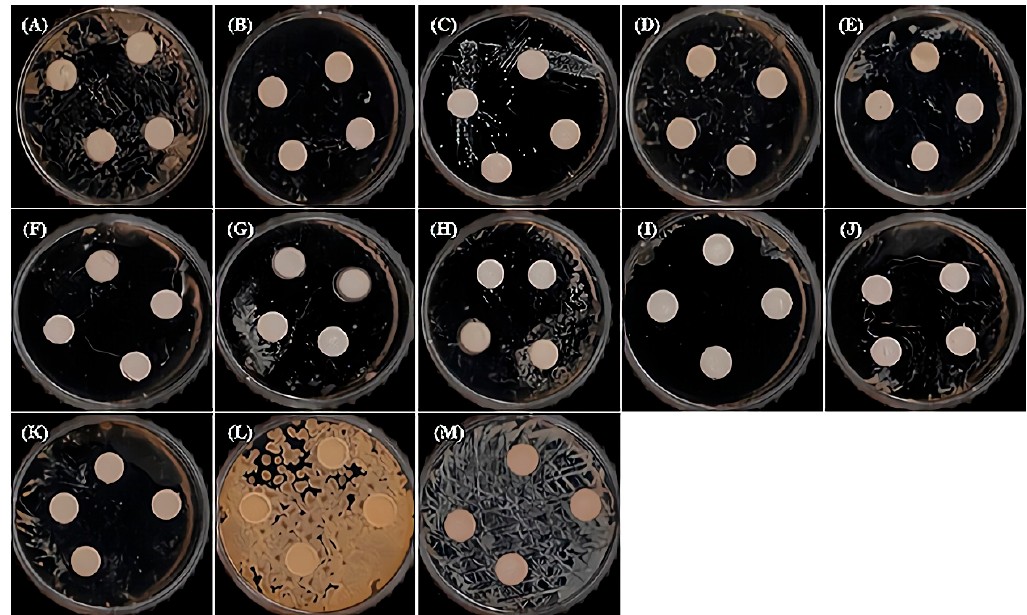
Figure 2. Representative photography for pathogenic and nonpathogenic bacterial culture on the natural extracts mixture series (M2). Pathogenic bacteria: ( A ) S. constellatus ( A , B ) S. sanguinis , ( C ) S. mutans , ( D ) S. constellatus ( B , E ) E. corro- den , ( F ) F. nucleatum , ( G ) S. sobrinus , ( H ) A. actinomycetemcomitans , ( I ) P. gingivalis , ( J ) P. nigrescens , ( K ) P. intermedia and nonpathogenic bacteria: ( L ) L. salivarius , ( M ) S.